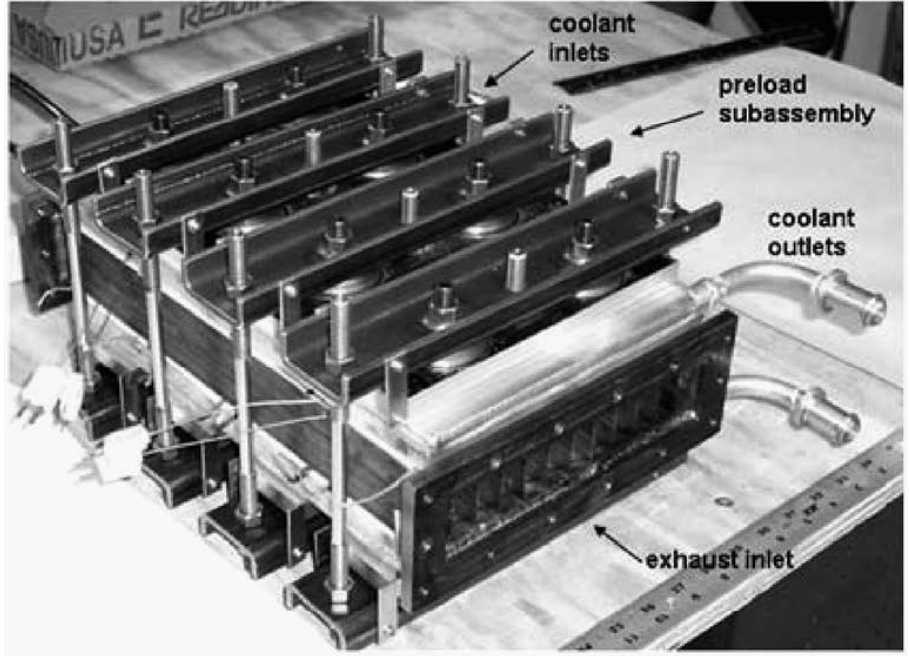
Figure 7. Automotive TEG system with sixteen TEG. Reprint with permission [57]; Copyright 2021, Elsevier.